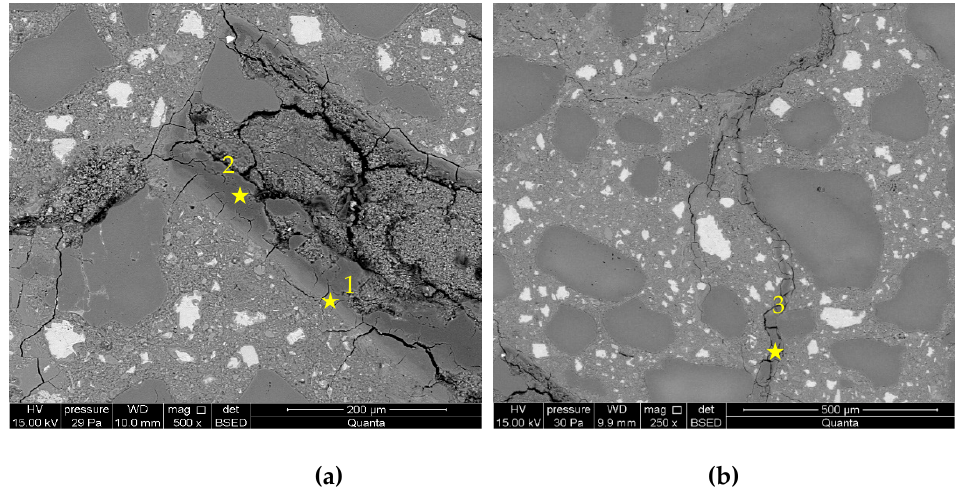
Figure 10. Microstructure images of mortars with metakaolin and lithium nitrate in 10% of metakaolin and [Li/Na + K] = 0.74 samples: ( a ) ASR gel in aggregate; ( b ) ASR gel in cement paste. X-ray microanalysis at location 1 – 3 (see Table 4).